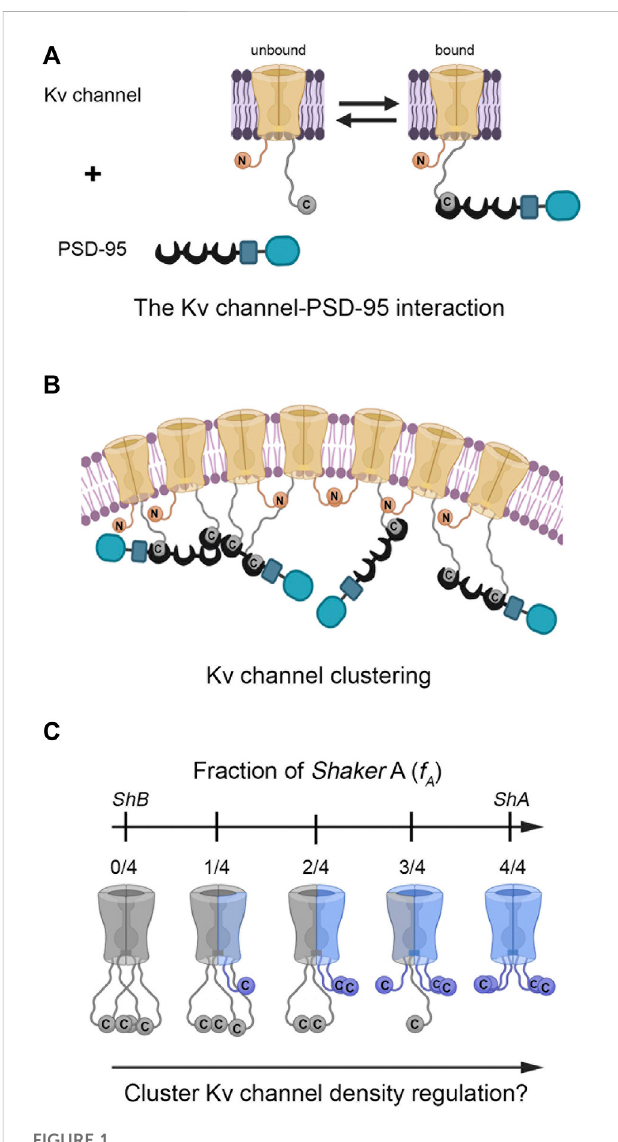
FIGURE 1 Does hetero-oligomeric Kv channel subunit assembly regulate PSD-95-mediated Kv channel clustering? (A) Schematic representation ofthe ‘ ballandchain ’ -likemechanismforKvchannelbindingtothePSD- 95 scaffold protein. In this mechanism, the extended ’ chain ’ at the channel C-terminal binds PSD-95 upon interaction of the chain- tethered peptide ‘ ball ’ with PSD-95 PDZ domain(s) in a manner reminiscent of the process of fast (N-type) channel inactivation. The Kv channel-PSD-95 interaction is thus entropy-controlled, dictated by Kv channel ’ chain ’ length. Given the stoichiometry of the interaction (Gomperts, 1996) and the ability of PSD-95 to aggregate (Hsueh et al., 1997), channel clustering occurs (B) . Note that clustering model is only an illustrative schematic model, the exact details of which await experimentalveri fi cationand which arebeyondthescope ofthecurrent study. The membrane-embedded portion of the Kv channel corresponds to the voltage-sensor and pore domains. The crescent, rectangular and rounded box shapes represent the PDZ, SH3 and guanylate kinase-like domains of the PSD-95 protein, respectively. For clarity, only one pair of N- and C-terminal chains of the tetramers are shown in panels A and B. (C) Heterologous subunit assembly of both Shaker A (light blue) and B (gray) variants can produce tetrameric channels with different numbers of the high-af fi nity A subunits, potentiallygivingrisetodistinctPSD-95-Kvchannelaf fi nitiesandcluster Kv channel densities. For clarity, the intrinsically-disordered N-terminal inactivation chains were omitted from the channel